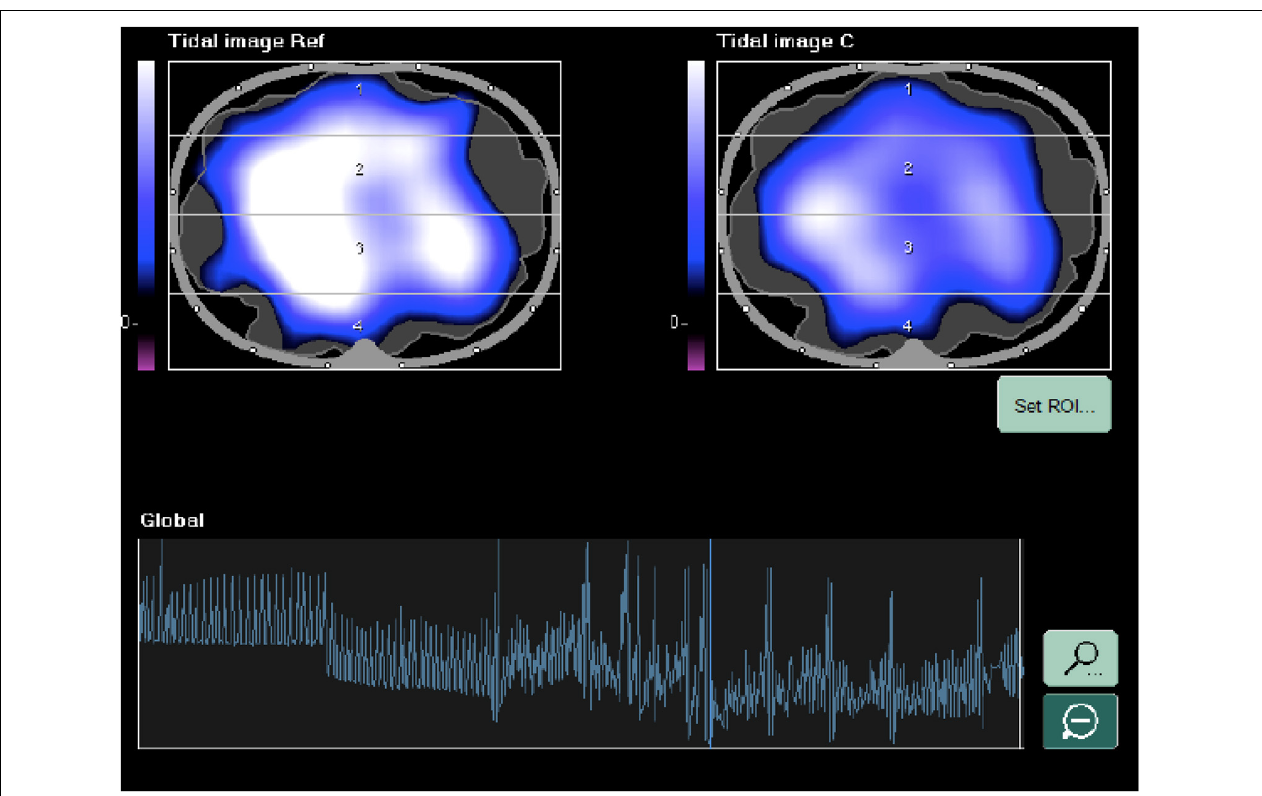
FIGURE 3 | Analysis from one CPAP decremental trial and change in ventilation distribution in a patient who failed NIV and died (the huge variability of the signal in the final step of the trial highlights the fatigue).